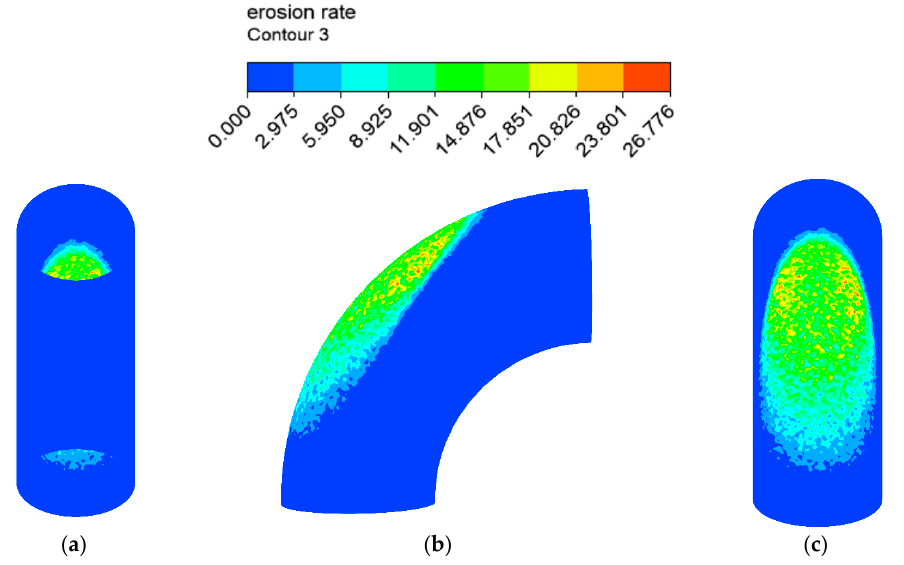
Figure 13. Distribution of the erosion rate: ( a ) view from +Y; ( b ) view from +X; ( c ) view from − Y.